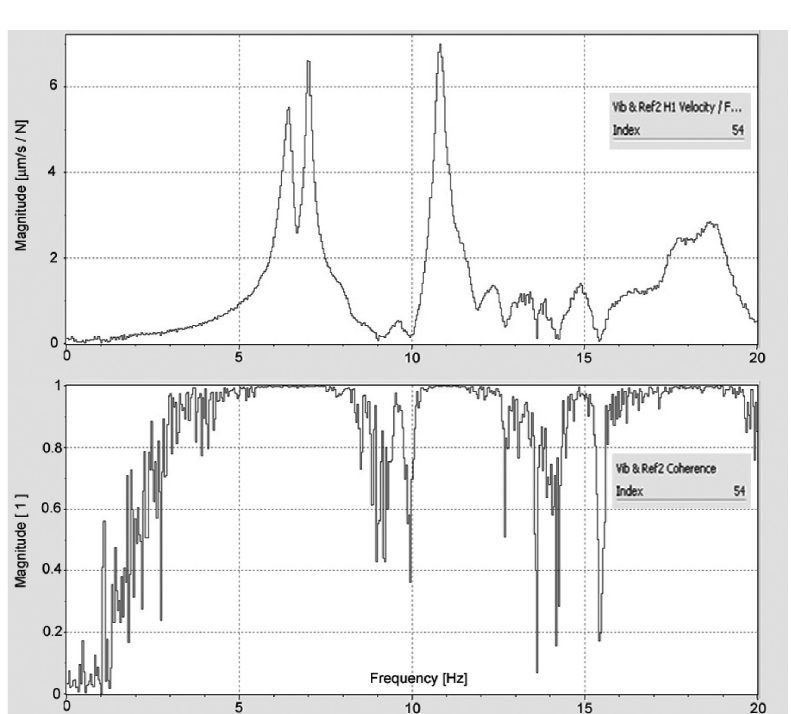
Fig. 7. Measured FRF in a selected measurement point and corresponding coherence